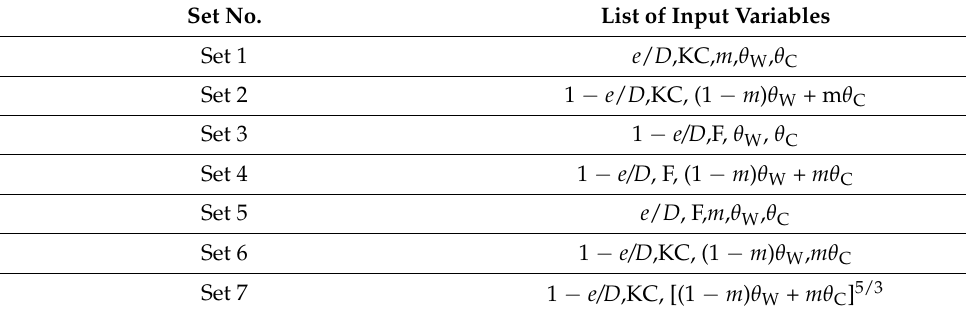
Table 1. Optimal selection of input variables. Set